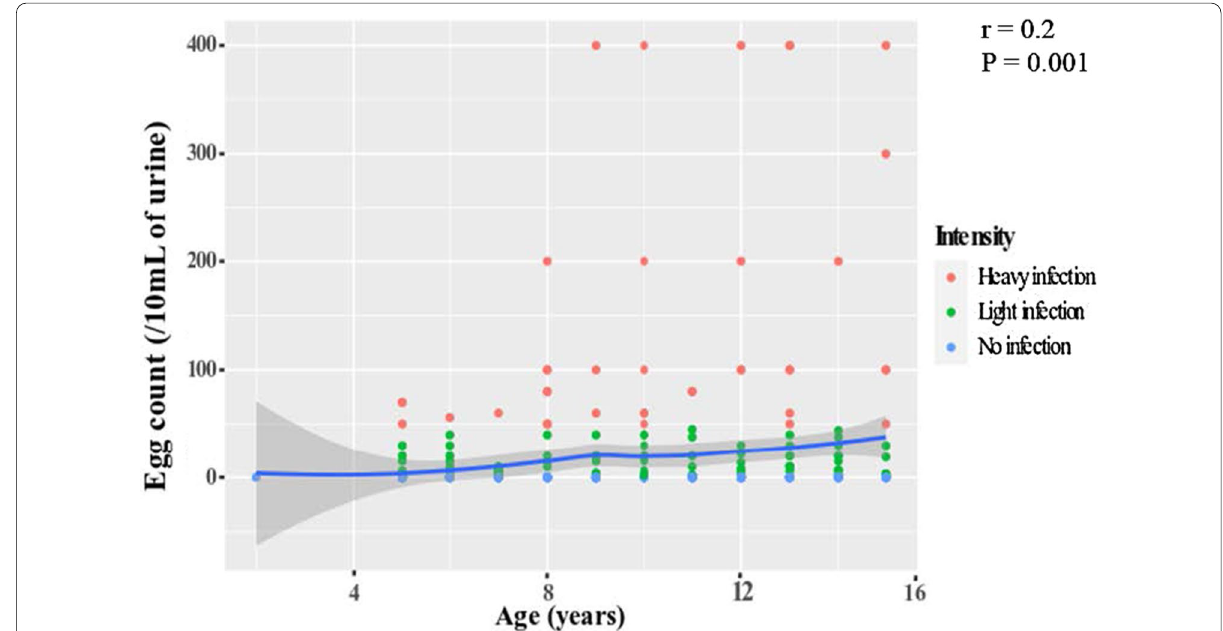
Fig. 2 Correlations between egg count and age of the participants